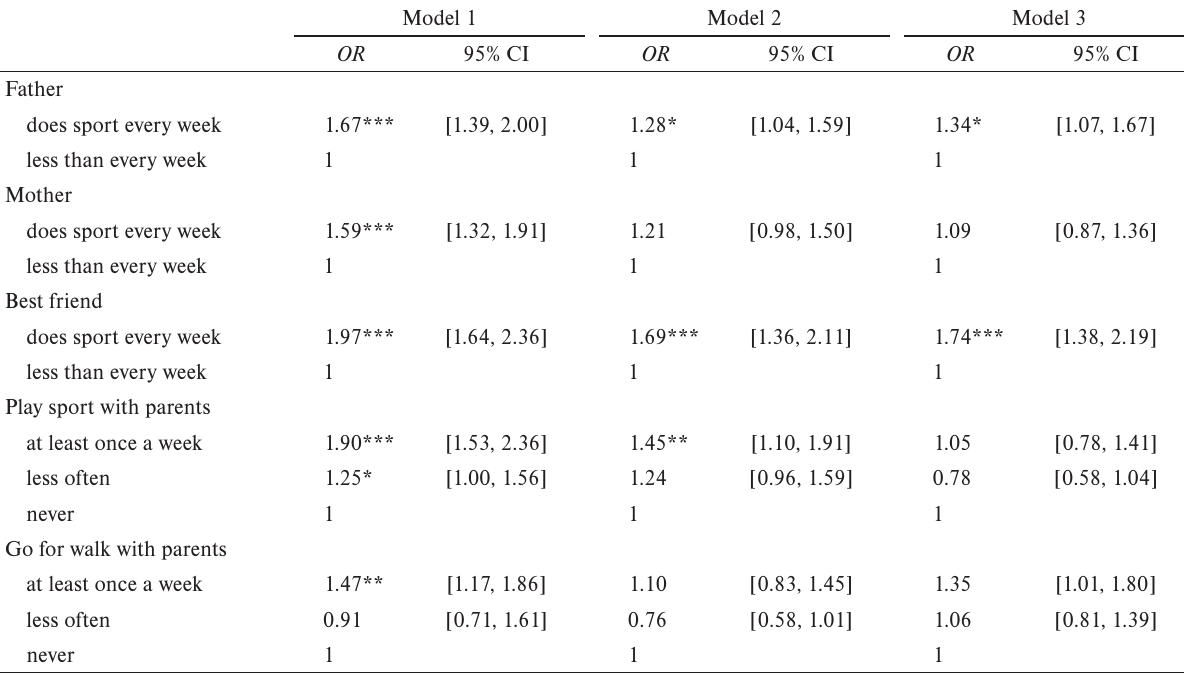
The association between potential parental and peers’ correlates, and sufficient moderate-to-vigorous physical activity of adoles- cents, logistic regression (3,012 Slovak adolescents aged 12.5–16.0 years, 50.2% boys, approached in 2014 within HBSC